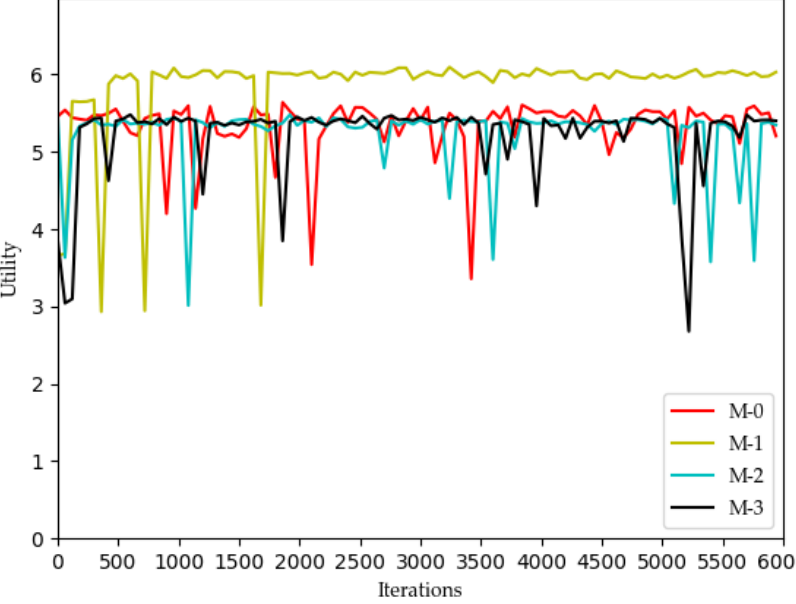
Figure 6. Optimization curve of SE for each MVNO in the lower model based on DQN